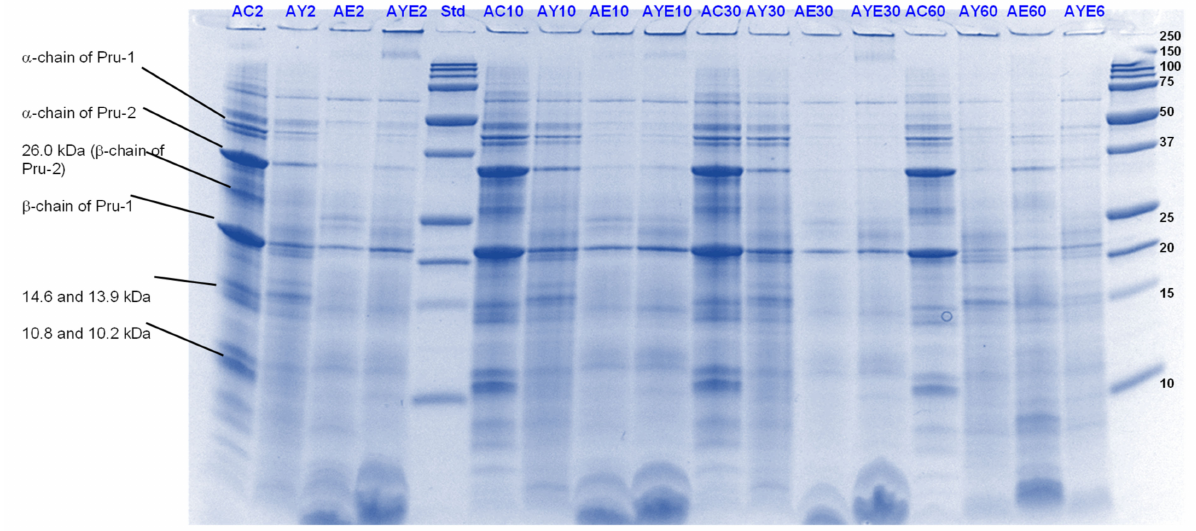
Figure 12. Tricine SDS-PAGE electrophoretogram of almond (A) digests after 2, 10, 30, and 60 min of simulated oral gastric digestion in the presence or absence of SunGold (Y) kiwifruit extract. AC, almond (A) control without any digestive enzymes; AY, with added gold kiwifruit extract but no digestive enzymes; AE, with digestive enzymes but no added kiwifruit extract; AYE, with both digestive enzymes and gold kiwifruit extract. Numbers 2, 10, 30 and 60 are gastric digestion times following 2 min of oral digestion. Bands (1–10) in the molecular weight standard lane correspond to molecular weights 250, 150, 100, 75, 50, 37, 25, 20, 15 and 10